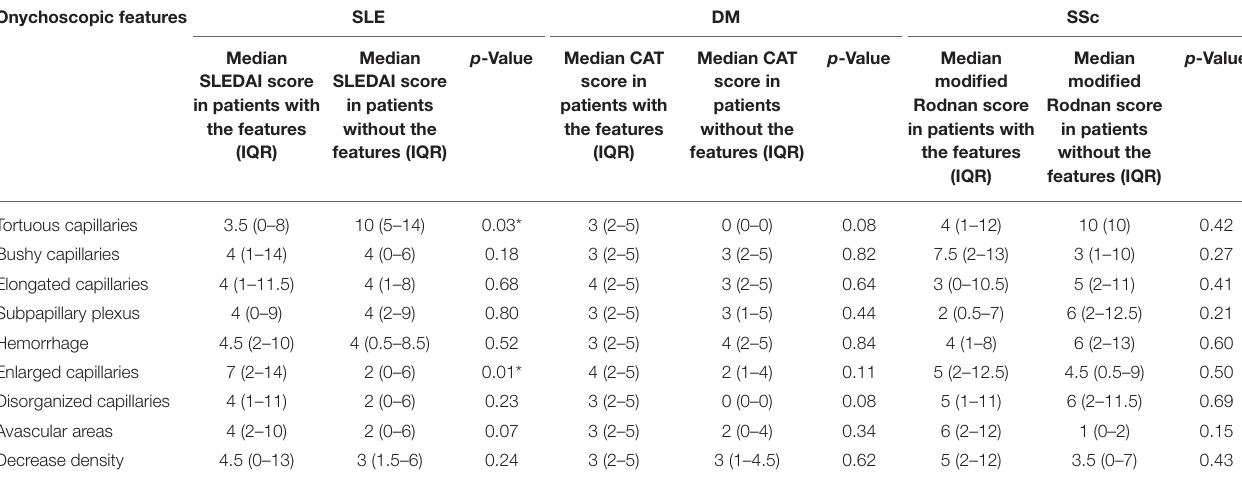
Median CAT Median CAT score score in